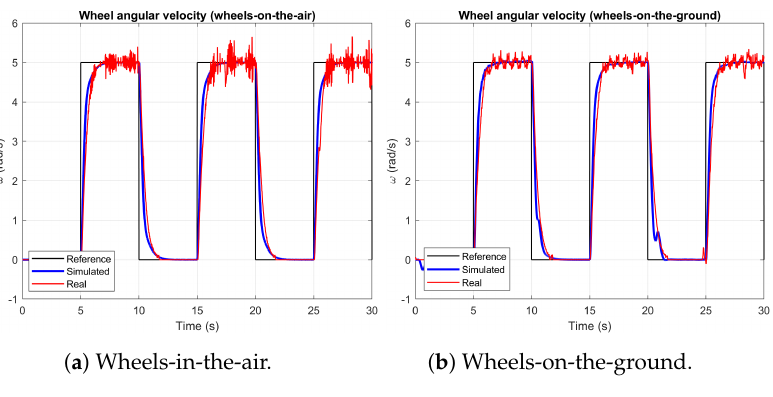
Figure 8. Closed-loop